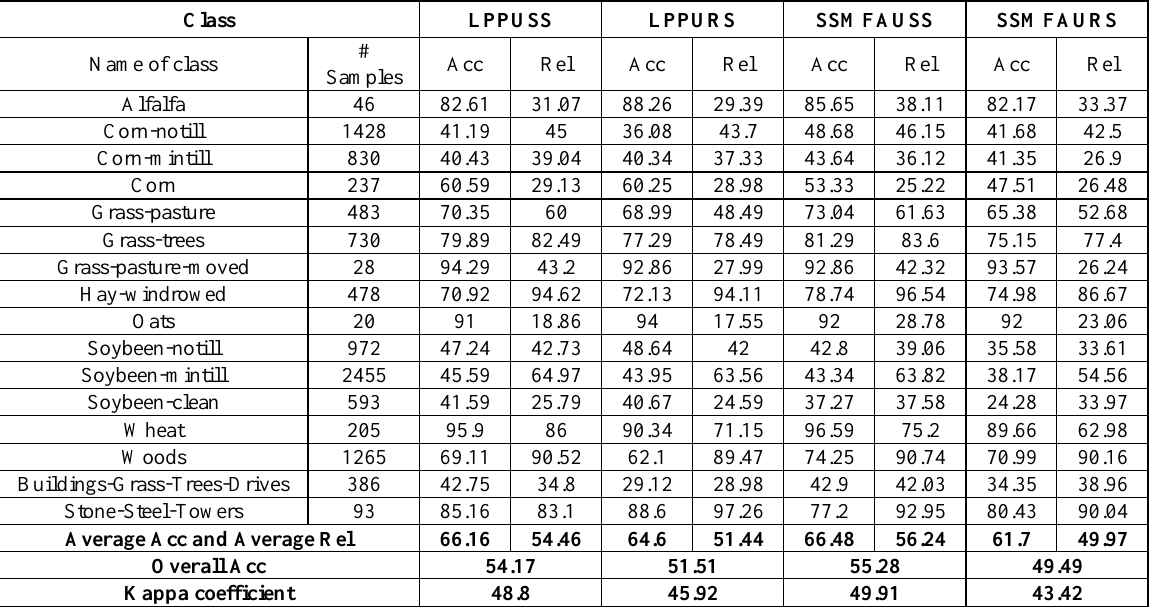
and 15 extracted features